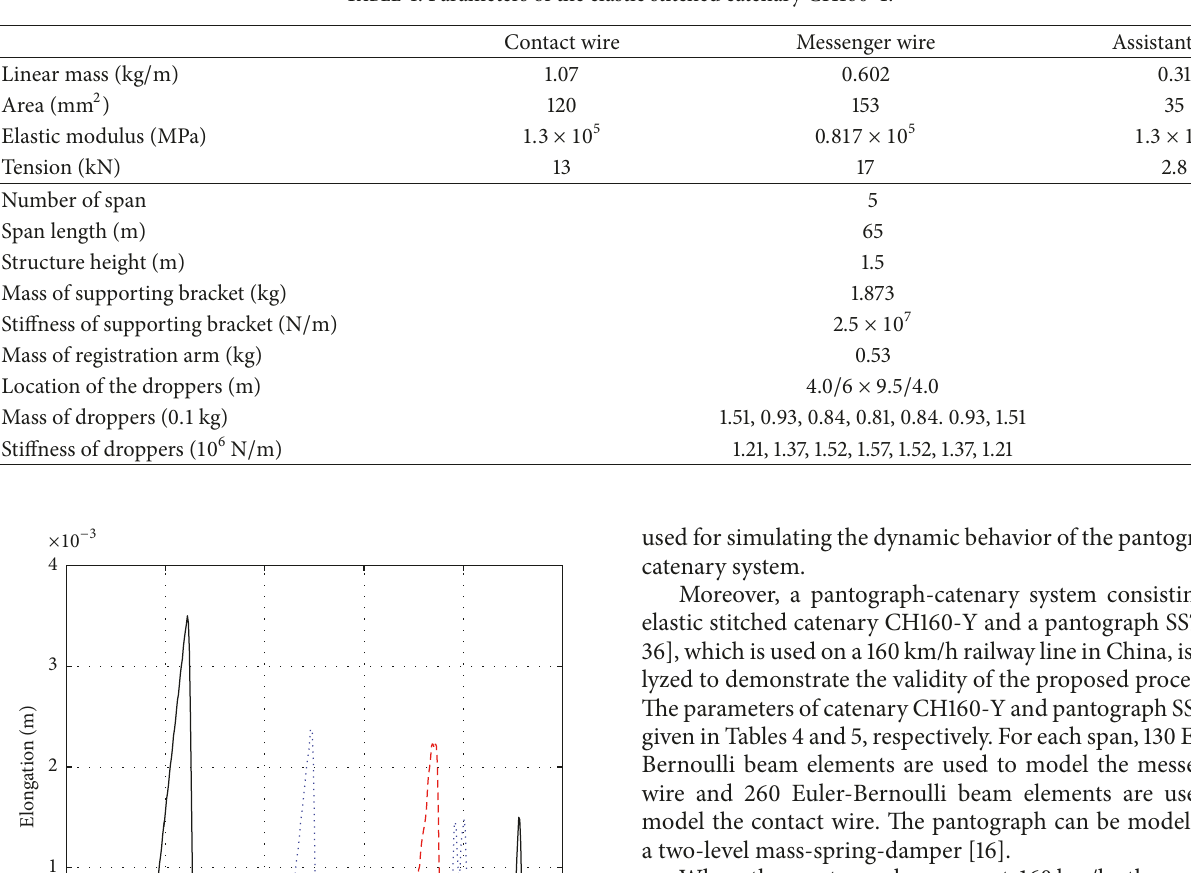
Table 4: Parameters of the elastic stitched catenary CH160-Y.